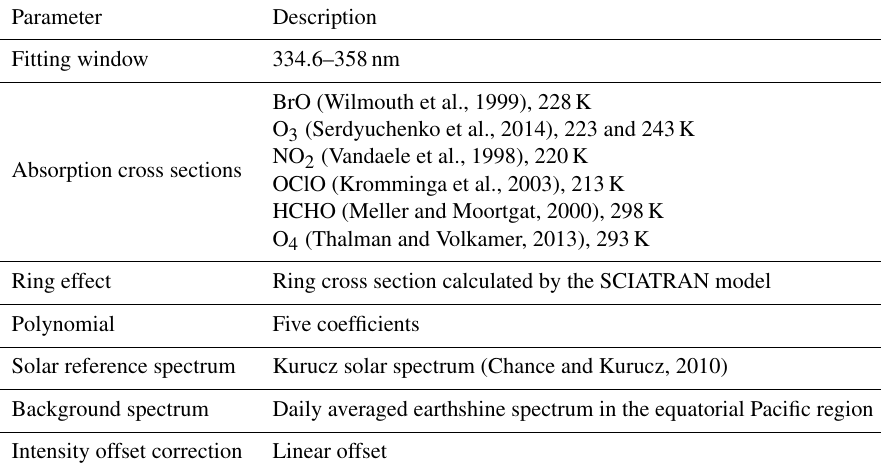
Table 1. Summary of DOAS settings used for the GOME-2 BrO slant column retrievals.